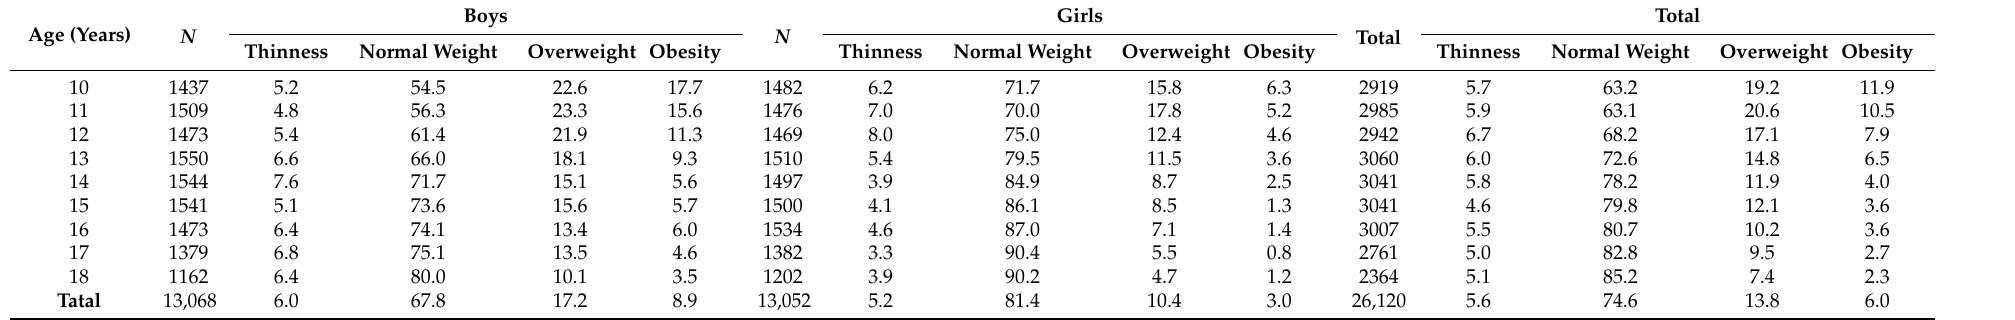
Table 2. Prevalence of different nutritional status in children and adolescents aged 10–18 years (%).